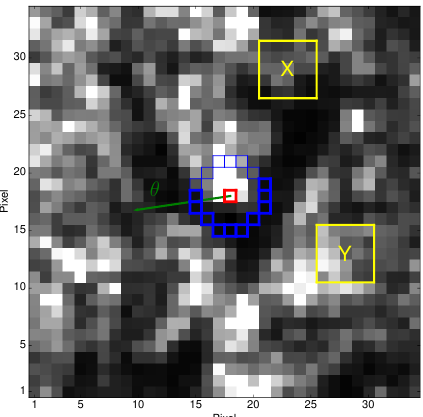
Figure 1. Subset of the first image from Fram Strait pair (Ta- ble 1) with centre at 2.31 ◦ W, 81.70 ◦ N and pixel spacing of 80m. The centre pixel (red) is recognized as keypoint since (cid:62) 9 contigu- ous pixels (bold blue) of the surrounding blue circle have inten- sity values smaller than the centre minus threshold t . The orienta- tion θ of the keypoint is shown with a green arrow. The displayed area (34 × 34 pixels) around the keypoint represents the considered patch p used for feature description. The yellow 5 × 5 pixels sub- windows X and Y are an example for a possible binary test sampling pair with p(X)<p(Y) and hence, τ(p ; X , Y) = 1 (Eq.